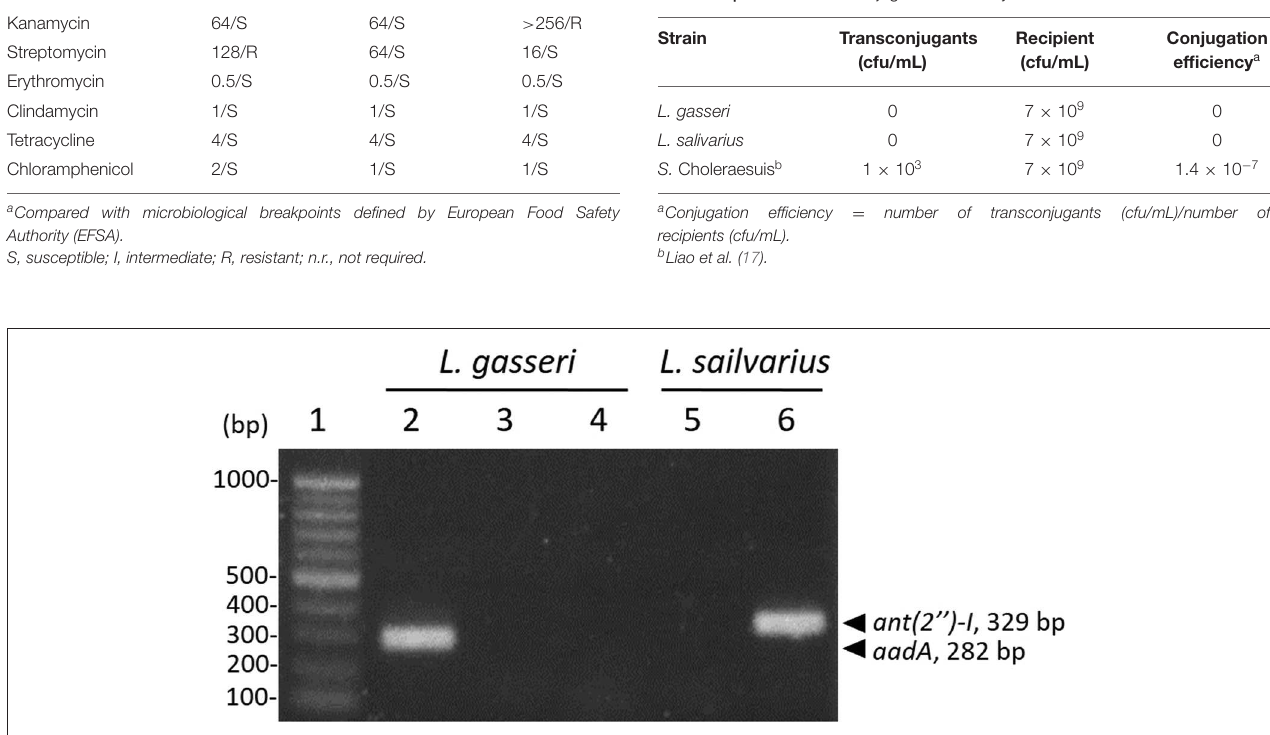
TABLE 5 | Calculation of conjugation efficiency.